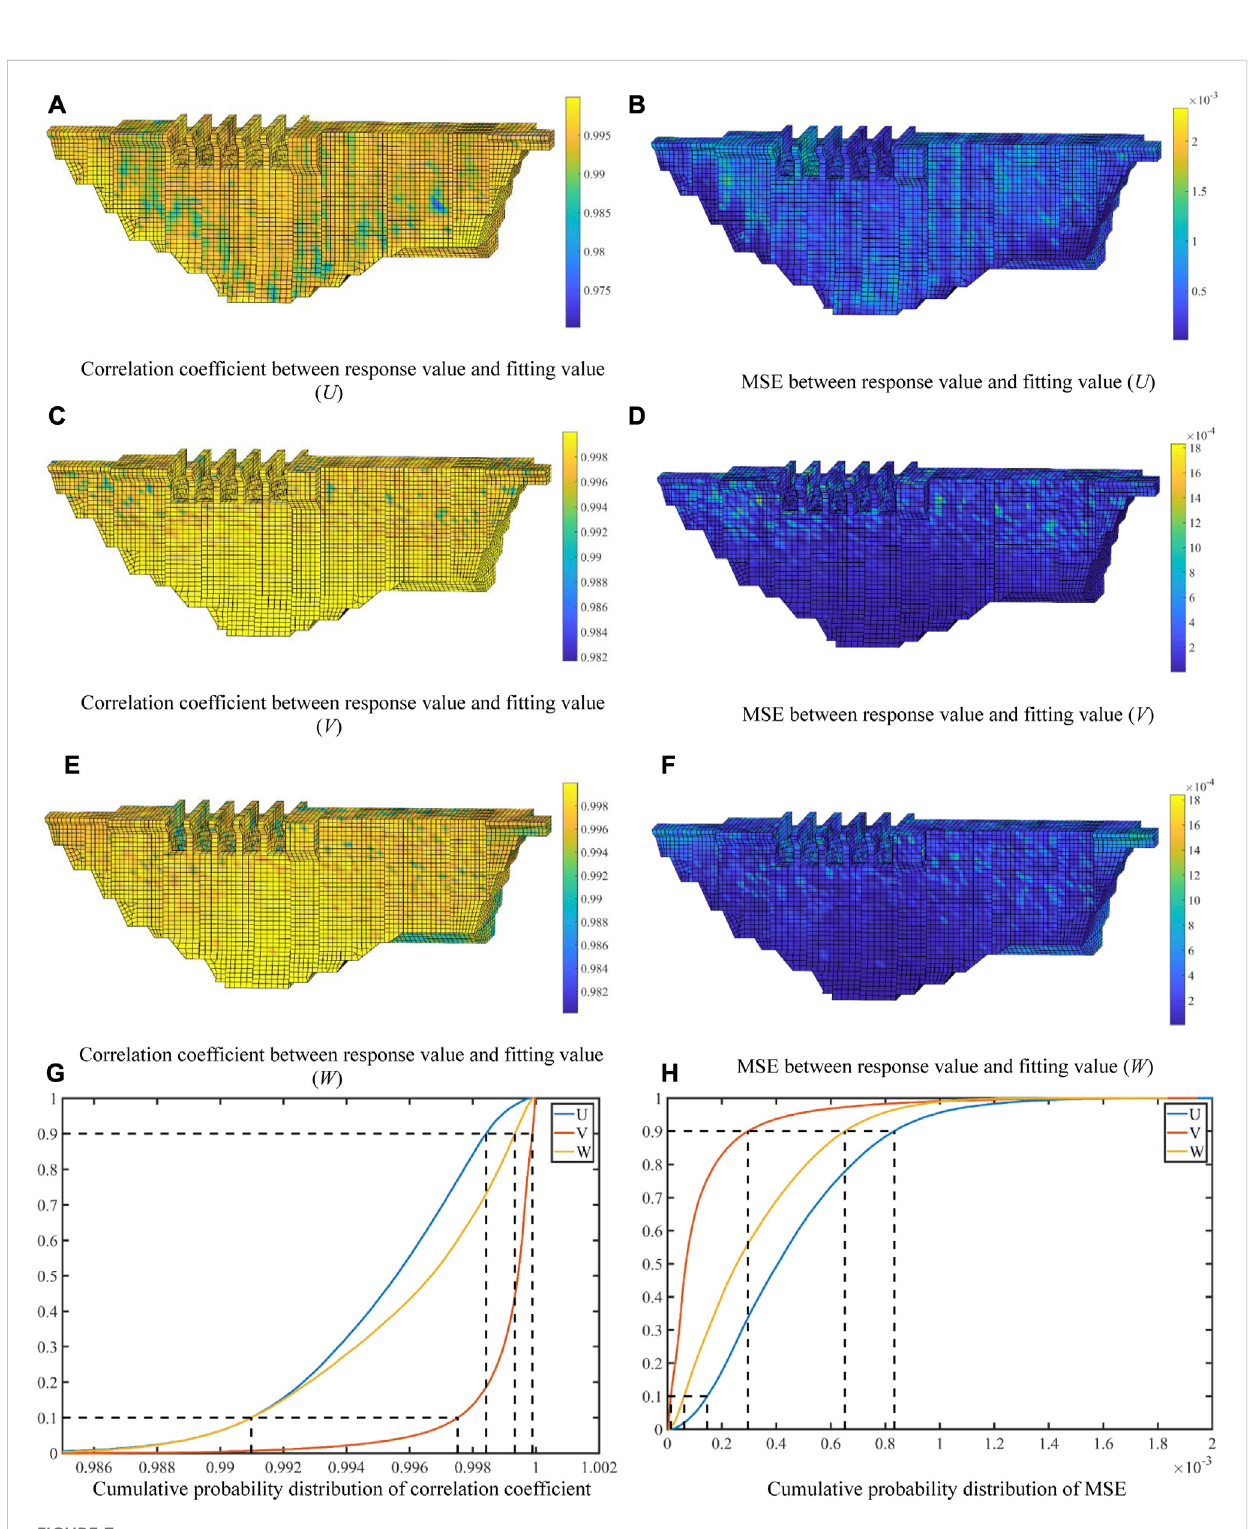
FIGURE 7 (A – F) correlation coef fi cient and MSE distribution of deformation behavior surrogate model within the dam body; (G,H) cumulative probability distribution of correlation coef fi cient and MSE of deformation behavior surrogate